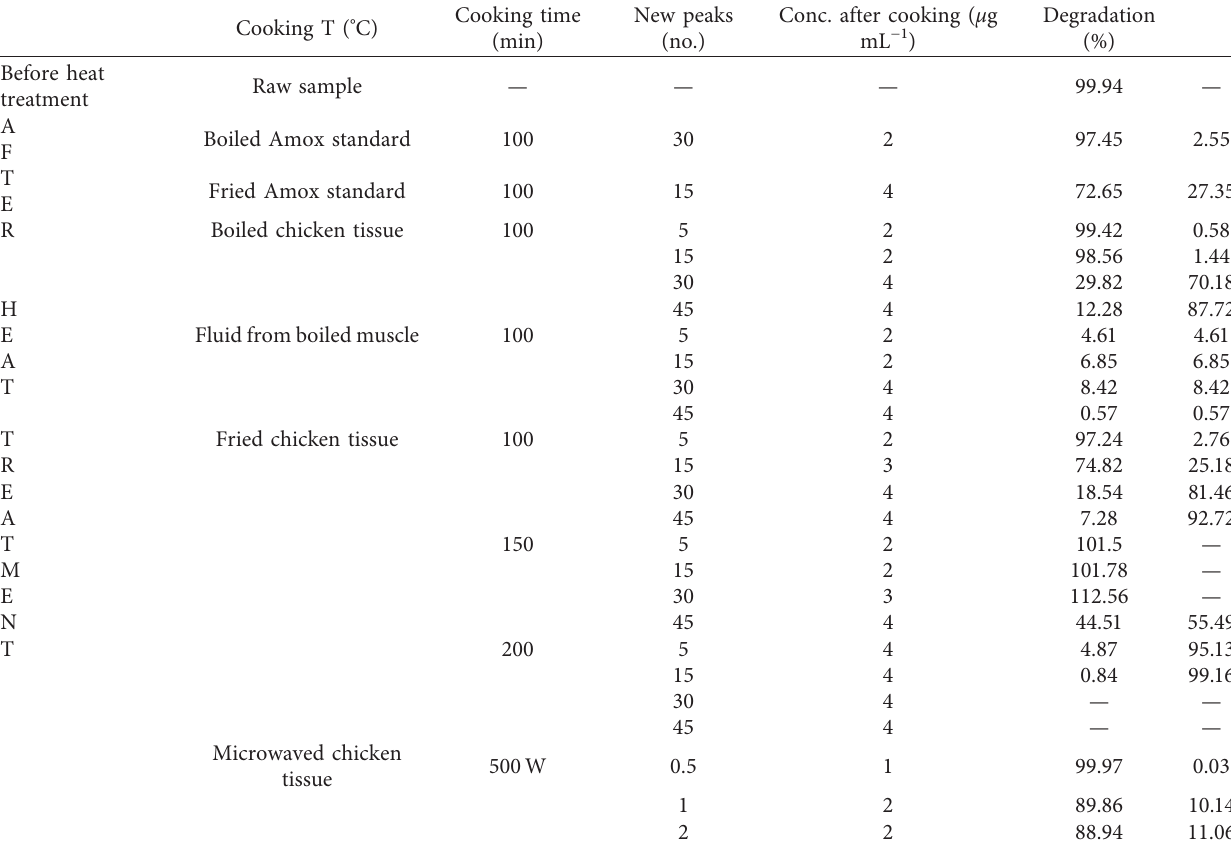
Table 1: The effect of various types of cooking processes on the concentration of Amox residues, in raw and cooked muscle samples.